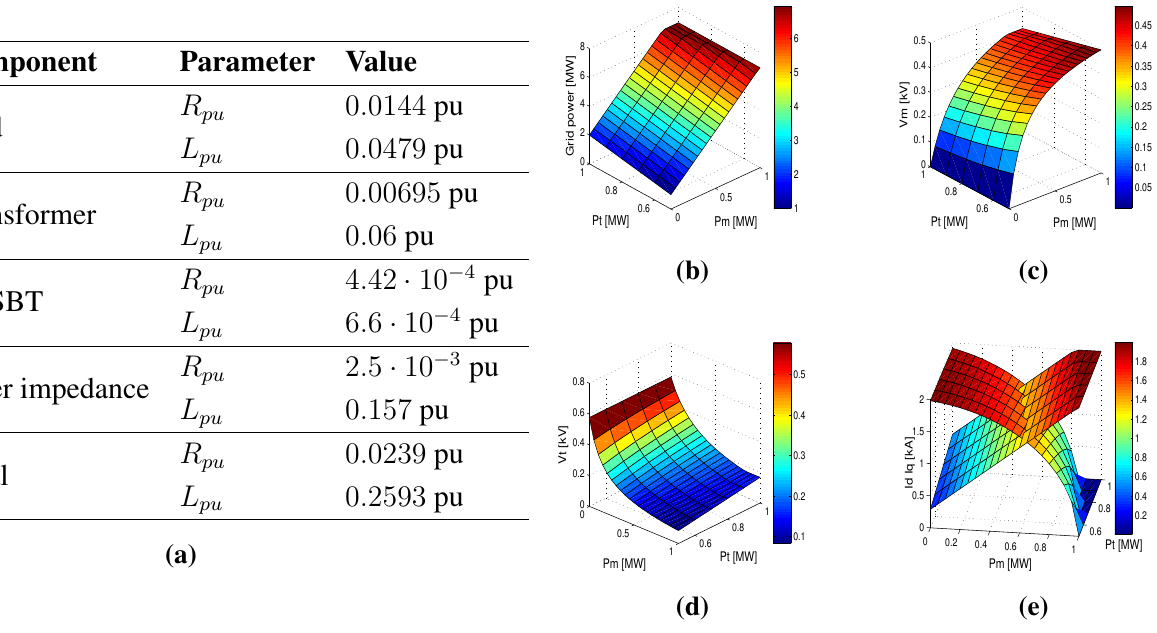
Figure 4. Circuit parameters used and optimization results represented as a function of the single-phase and three-phase available power. ( a ) Simulation positive sequence parameters per unit system; ( b ) power delivered to the grid in MW; ( c ) single-phase voltage phasor amplitude, kV; ( d ) three-phase voltage phasor amplitude, kV; ( e ) Id and Iq current surfaces, kA.